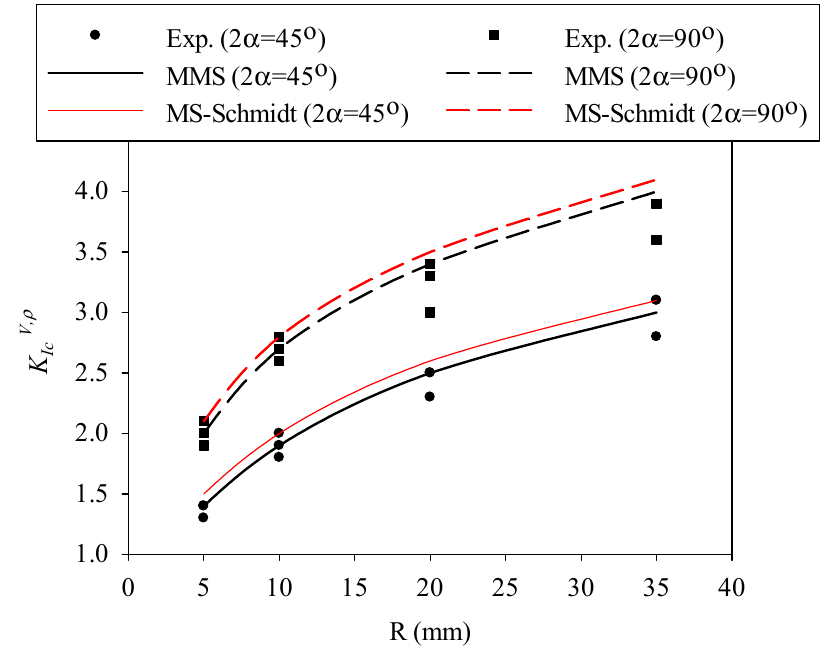
Figure 10. Variation in K IcV, ρ with specimen size for RVNSCB specimens made of GPPS. Predictions provided by the MS–Schmidt and the MMS criteria, and experimental data.